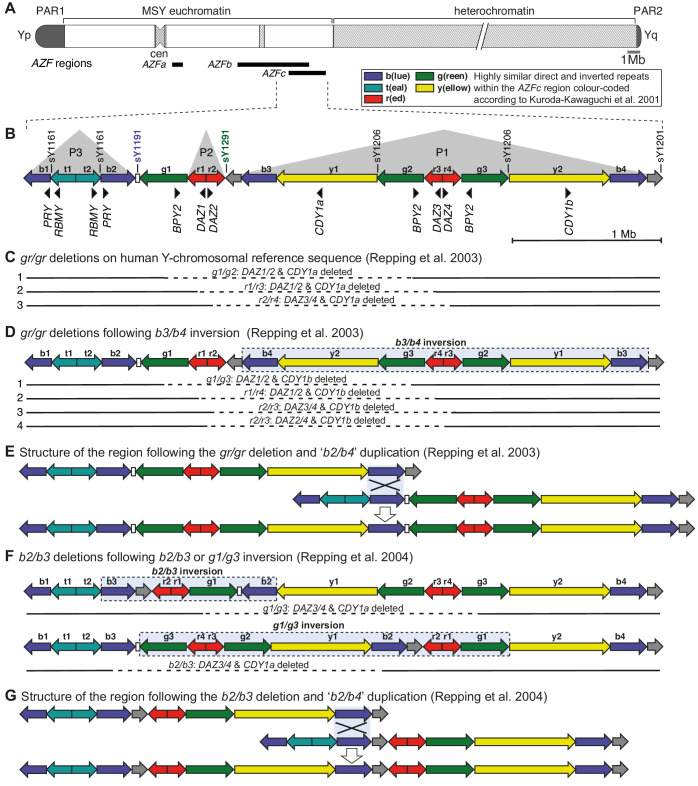
The human Y chromosome and the Azoospermia Factor (AZF) regions.(A) The human Y chromosome drawn to approximate scale with regions of AZFa, AZFb, and AZFc deletions shown below as black bars. PAR, pseudoautosomal region; MSY, male-specific region of the Y chromosome; cen, centromere; AZF, azoospermia factor region. (B) Structure of the AZFc region on human Y-chromosomal reference sequence with approximate locations of protein-coding genes and STS (sY) markers used for detection of partial AZFc deletions (Kuroda-Kawaguchi et al., 2001). Alternative involved regions in gr/gr deletions arising on (C). The human Y-chromosomal reference sequence and (D) the Y chromosome with a preceding b3/b4 inversion. The approximate region removed by each deletion is shown as a dashed line. (E) Structure of the AZFc region undergone the gr/gr deletion and the proposed model of homologous recombination leading to the subsequent ‘b2/b4’ duplication. The light blue box denotes the recombination targets. The duplication is presumably the result of recombination between sister chromatids. (F) Reported models for b2/b3 deletions arising on the Y chromosomes with preceding b2/b3 or g1/g3 inversions. The approximate region removed by each deletion is shown as a dashed line. (G) Structure of the AZFc region undergone the b2/b3 deletion and the proposed model of homologous recombination leading to the subsequent ‘b2/b4’ duplication. The light blue box denotes the recombination targets. The duplication is presumably the result of recombination between sister chromatids.